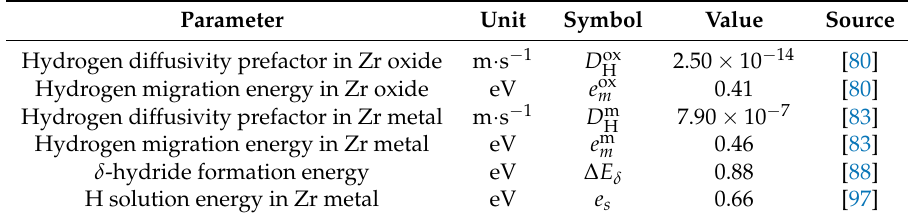
Table 1. Zr-H energetics used in the model with the respective source.